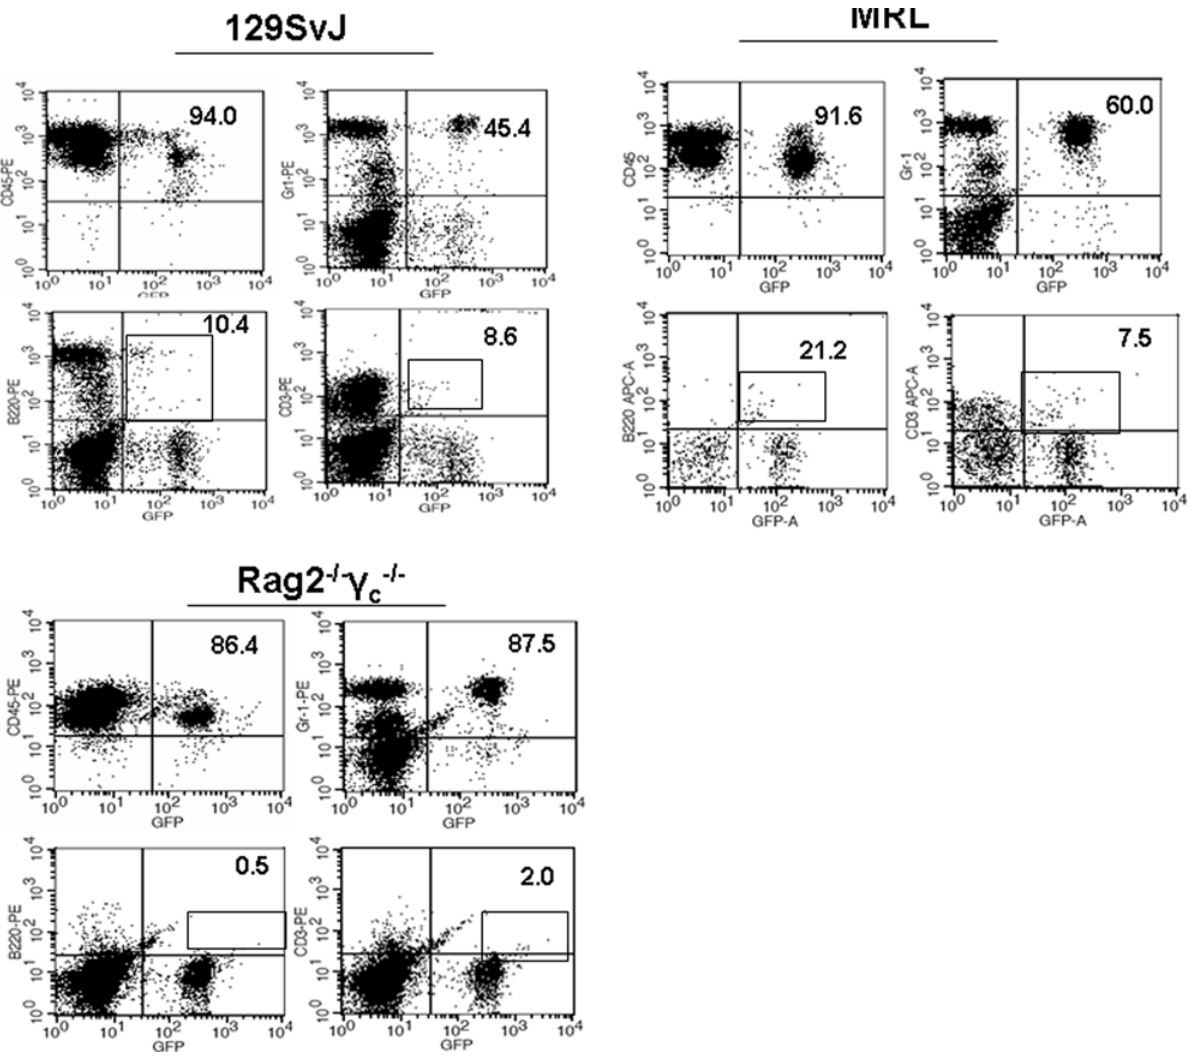
Figure 3. Poor T and B cell development in HPC-derived hematopoietic cells. Using flow cytometry, chimeric 129SvJ, MRL, and Rag2 2 / 2 c c 2 / 2 mice were analyzed for donor cells at 28 days post-transplantation. In all three strains, Gr-1 + cells were the predominant sub-population with lower cell numbers of B220- and CD3-expressing B and T cells, respectively. The percentages are calculated within the GFP + population.